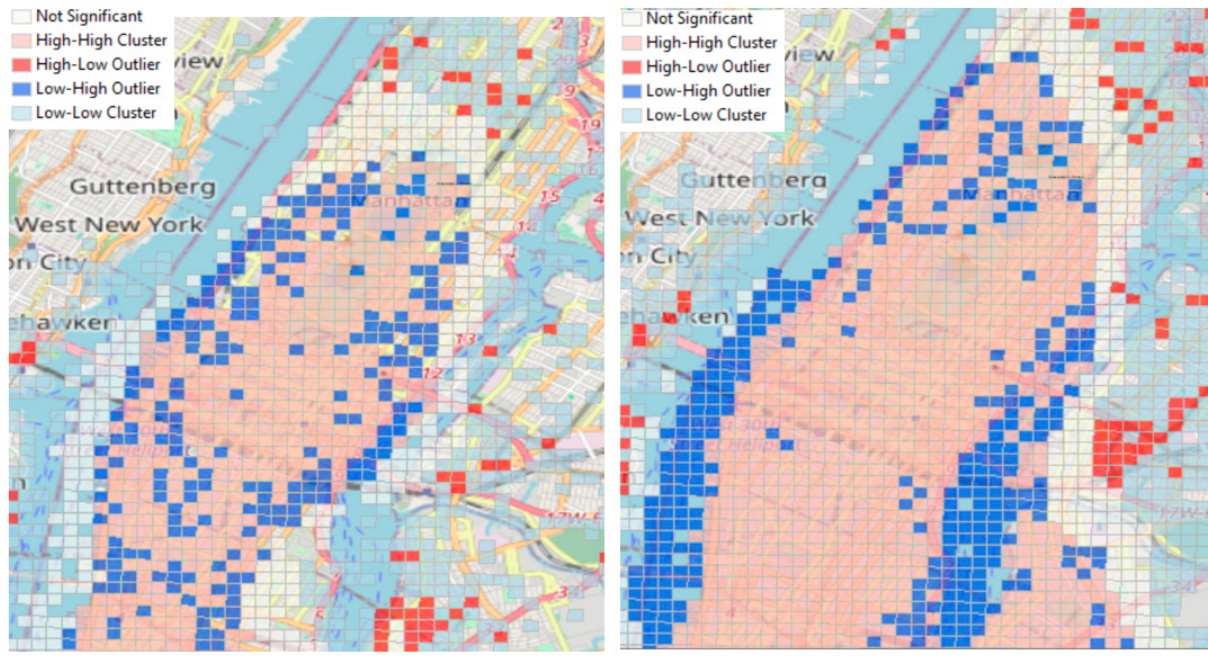
Figure 6. Heat map cluster analysis comparison (based on cluster Moran’s I analysis): tourism photographers-based ( left ) and photo-based ( right ) (background: OpenStreetMap).